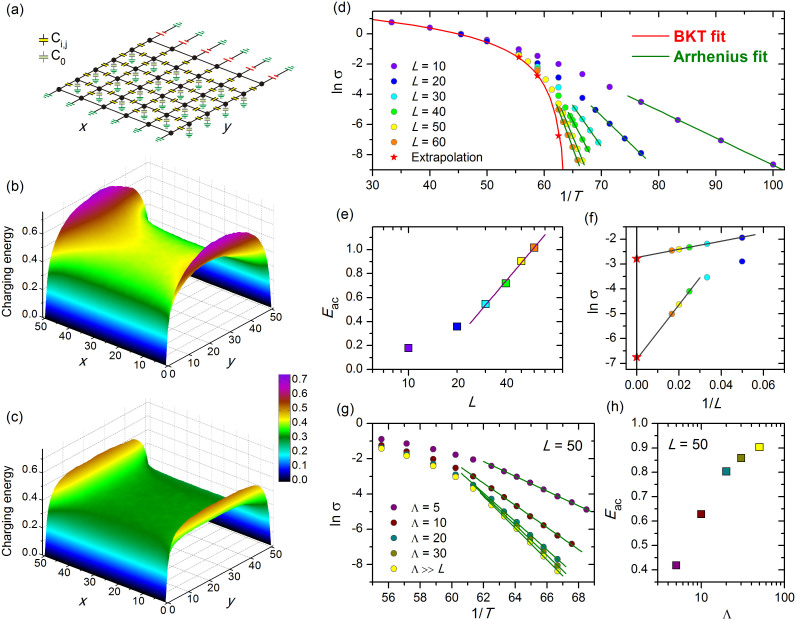
Two dimensional regular network of capacitors (2DCN).(a) A sketch of a square network of capacitors that models electric properties of an insulating high-κ nanosheet. Capacitors connecting the nodes have capacitances {Ci,j}; nodes are linked to the ground by capacitors with capacitances to the ground {C0}. The electrostatic screening length . (b) Three dimensional plot of the electrostatic energy of the excess charge in the network with the size L = 50 and in the absence of capacitances to the ground, i.e. with Λ → ∞. The network is connected to the leads at y = 0 and y = 50. (c) The same as (b) but with . The color scales is the same for both (b) and (c). (d) Logarithm of conductivity σ, shown by colored circles, as function of the inverse temperature, 1/T, for different system sizes listed in the legend and Λ → ∞. Straight solid lines are Arrhenius fits, σ ∝ exp(−Eac/T). The BKT red curve is given by Eq.(4) and fits the ln σ(1/T) values (shown by stars) obtained by extrapolation of the system size to infinity. (e) Size dependence of the activation energy Eac inferred from the Arrhenius fits of panel (d). (f) Plots of ln σ vs. 1/L for temperatures T = 0.016 (lower plot) and T = 0.017 (upper plot) giving conductivities for the infinite-size systems. The legend for symbols is the same as that in the panel (d). (g) Logarithm of conductivity σ, shown by colored circles, as function of the inverse temperature, 1/T, for different Λ listed in the legend for L = 50. Straight lines are Arrhenius fits. (h) Activation energies inferred from panel (g) as functions of Λ. The last yellow point depicts Λ = L = 50. The error bars in panels (d–h) are smaller than the size of the symbols and have not been shown.